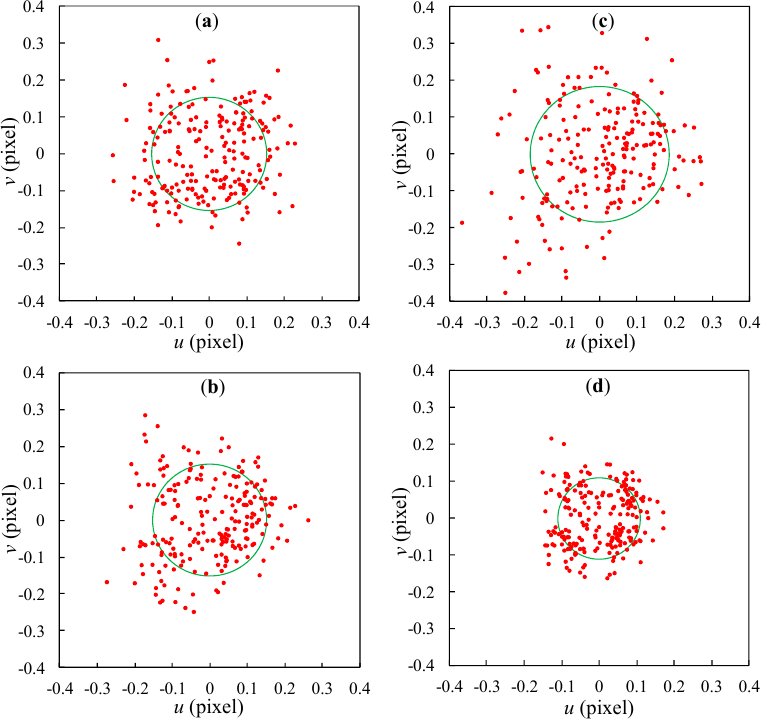
Figure 11. Scatter plots of re-projection errors (red dots) for ( a ) [16], ( b ) [20], ( c ) [24], and ( d ) proposed method. In each sub-figure, green circle is rendered with a radius equal to the mean re-projection error.